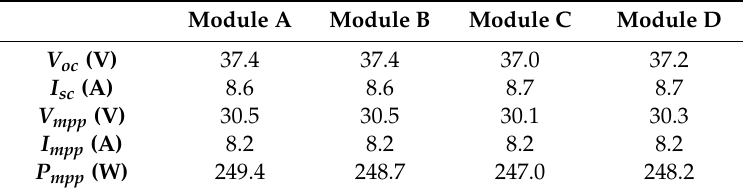
Table1. Parametersofeachmoduleatstandardtestconditions(STC),obtainedfromsolarsimulatortests.